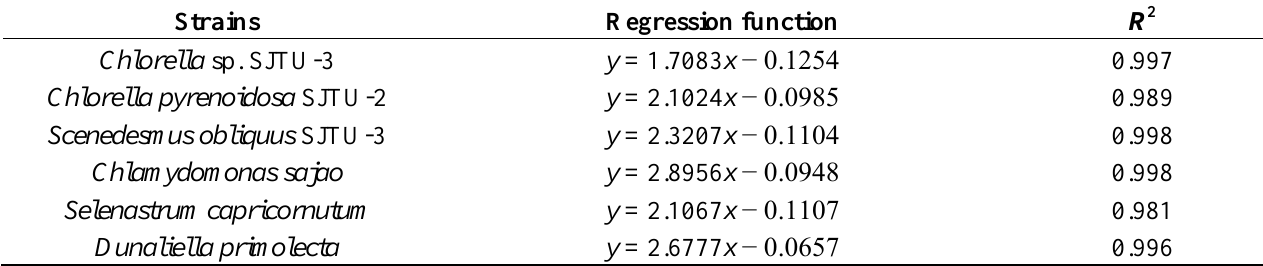
versus cell 570